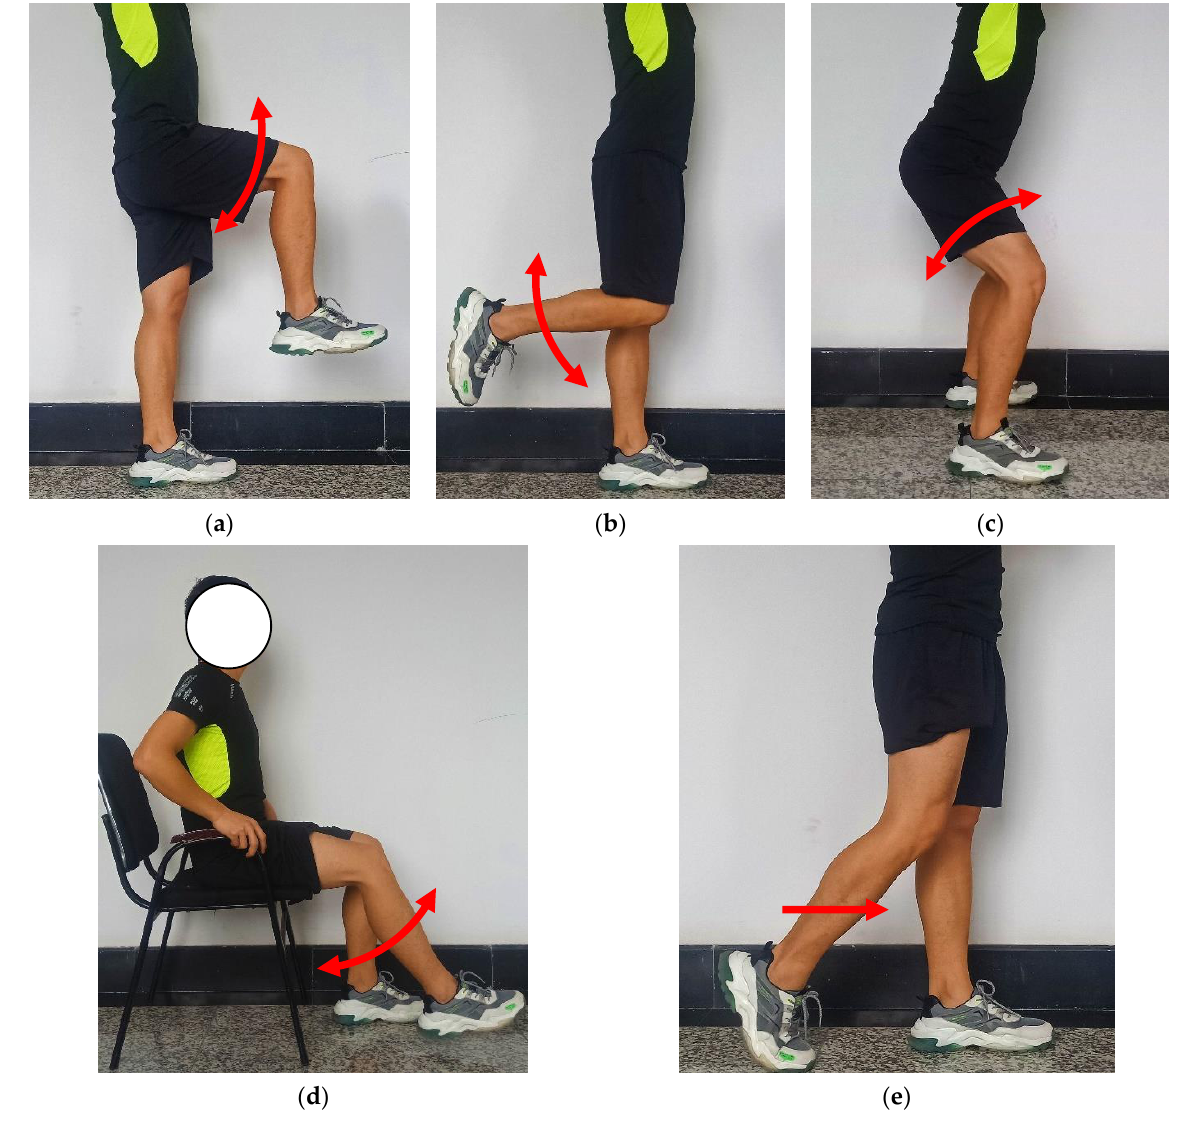
Figure 6. Five kinds of action demonstration: ( a ) Thigh-raising; ( b ) Calf-raising; ( c ) Squatting; ( d ) Knee Bending on Chair; ( e ) Walking.